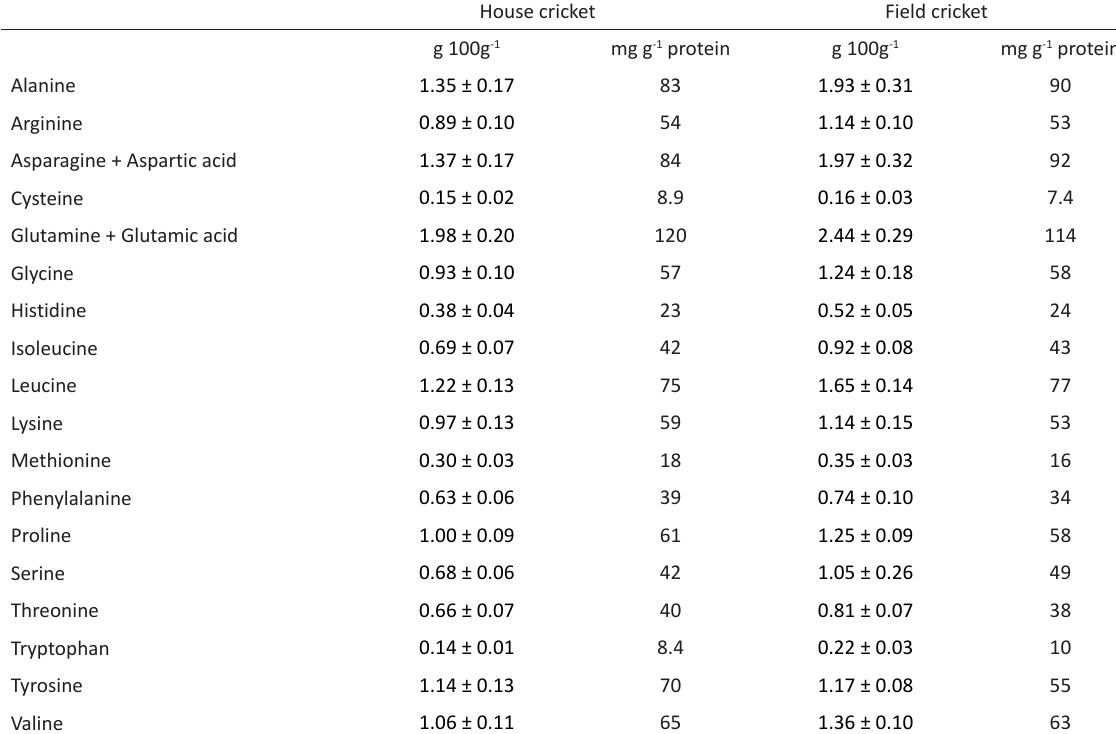
Table 2. Amino acid concentrations (mean ± sd) of the crickets as g 100g -1 fresh weight as well as proportions of individual amino acids as mg g -1 protein. n=18, except n=9 for cysteine, methionine, tyrosine and tryptophan House cricket Field cricket g 100g